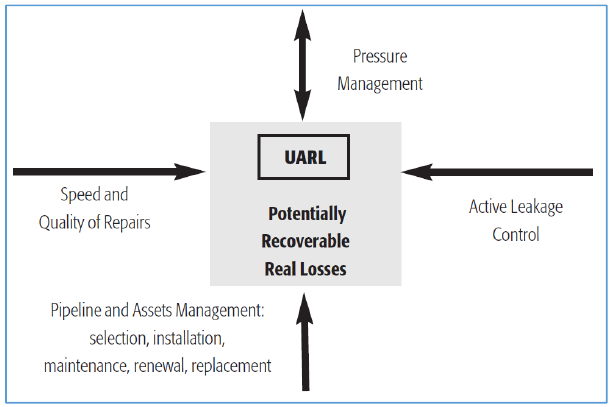
Figure 7. IWA real losses management conceptual structure [19]. UARL, Unavoidable Leakage Level.